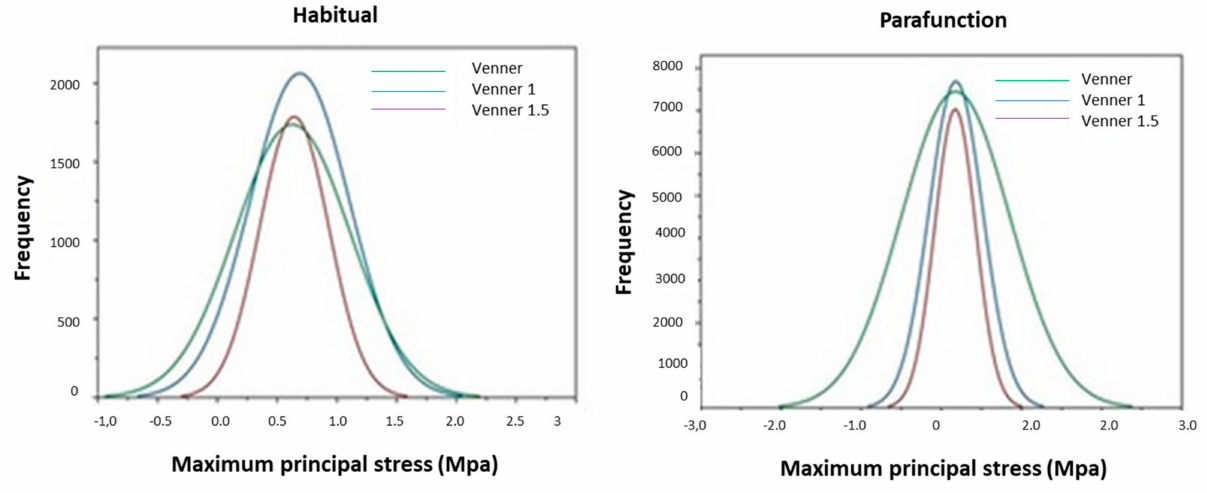
Figure 4. Representative graph of stress peaks in modified restorations during habitual function ( left ) and parafunction ( right ). The stress peaks at veneer and veneer with 1.5 extension is similar during habitual function, but for parafunction the stress peaks are higher for modification